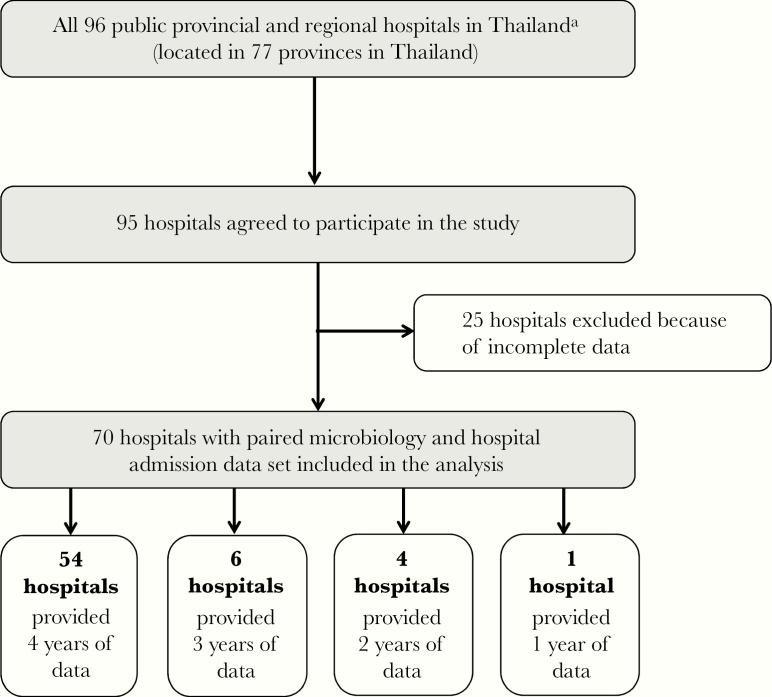
Flowchart of the study. aIn 2012, there were 68 public general hospitals (acting as secondary care hospitals) and 28 public regional hospitals (acting as tertiary care hospitals) in Thailand [24].